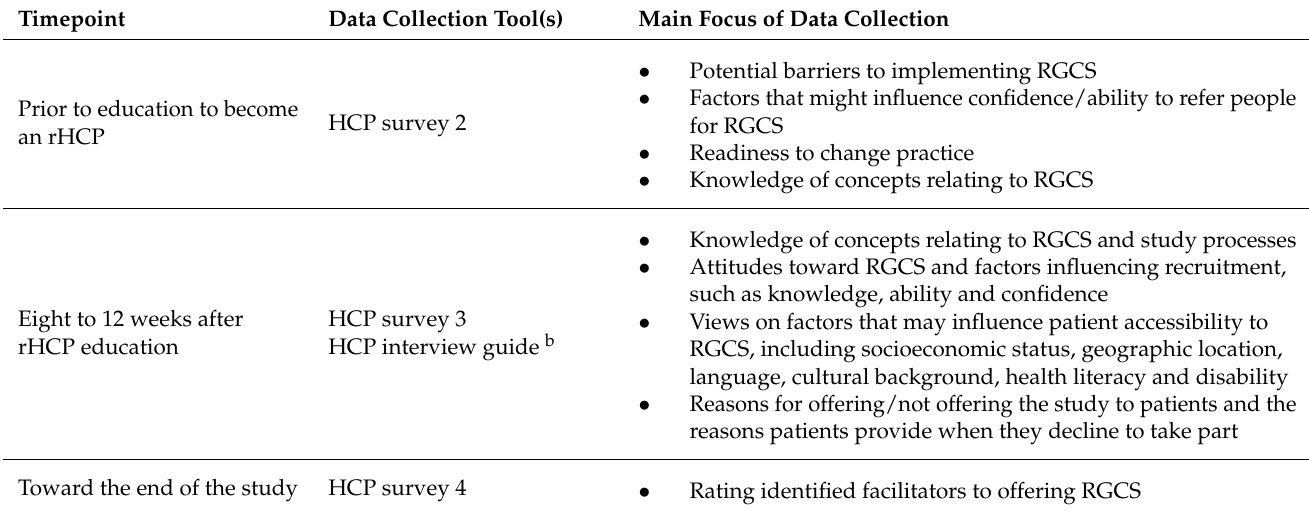
Table 2. Data collection tools for recruiting HCPs in the Mackenzie’s Mission study a